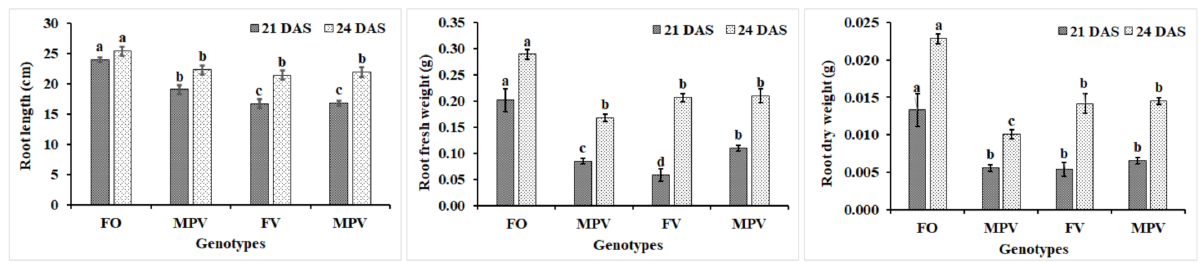
Figure 1. Assessment of the phenotypic parameters (root length, root fresh weight, and root dry weight of two rapeseed F1 hybrids (FO: high hybrid, FV: low hybrid) compared with the mid parent value (MPV) at 21 and 24 DAS. Bars represent the SD of three replicates. Different used letters indicate significant differences ( p <0.05) within phenotypic parameters using Tukey’s HSD (Honest Significant Difference) test. FO: High hybrid, FV: Low hybrid, MPV: Mid parent